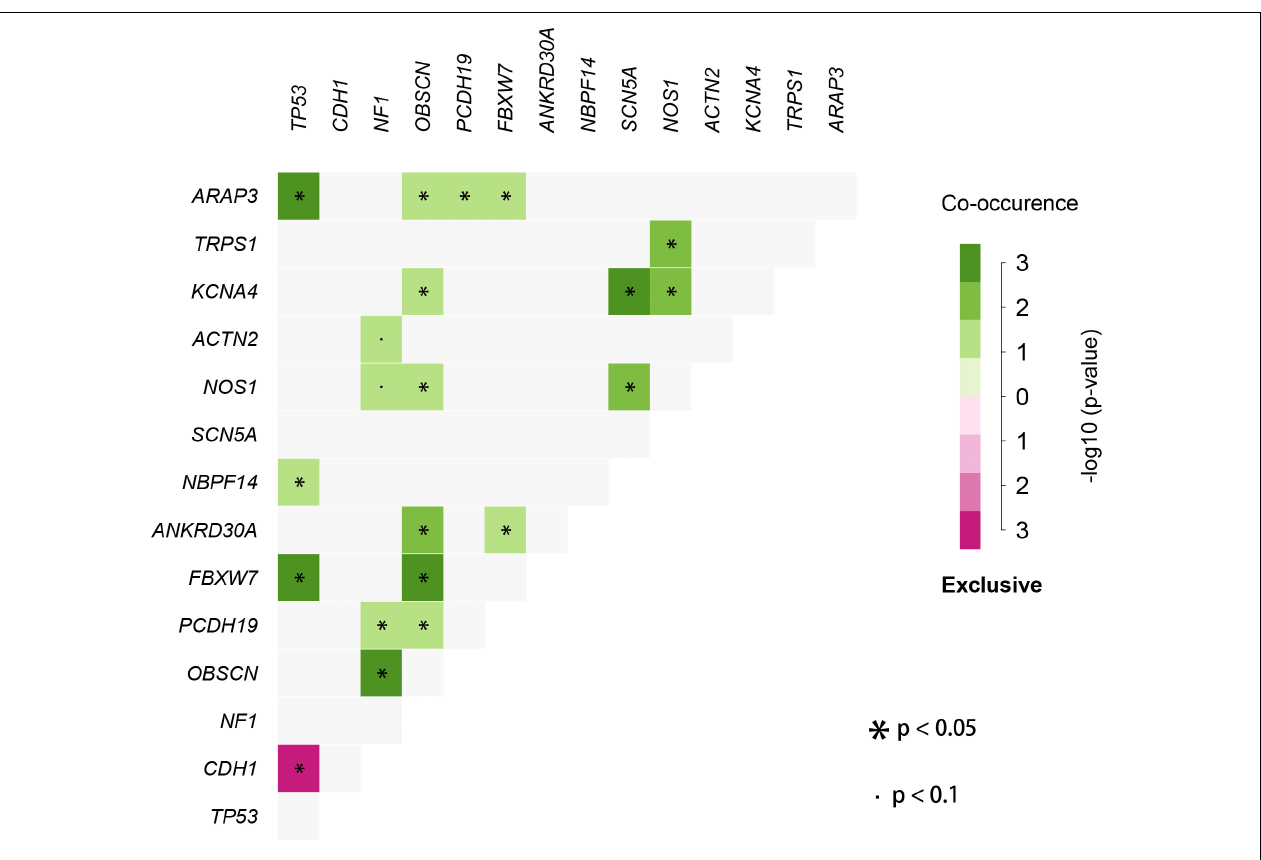
FIGURE 3 | Co-occurrence and mutual exclusivity plots between mutation genes correlated with immune